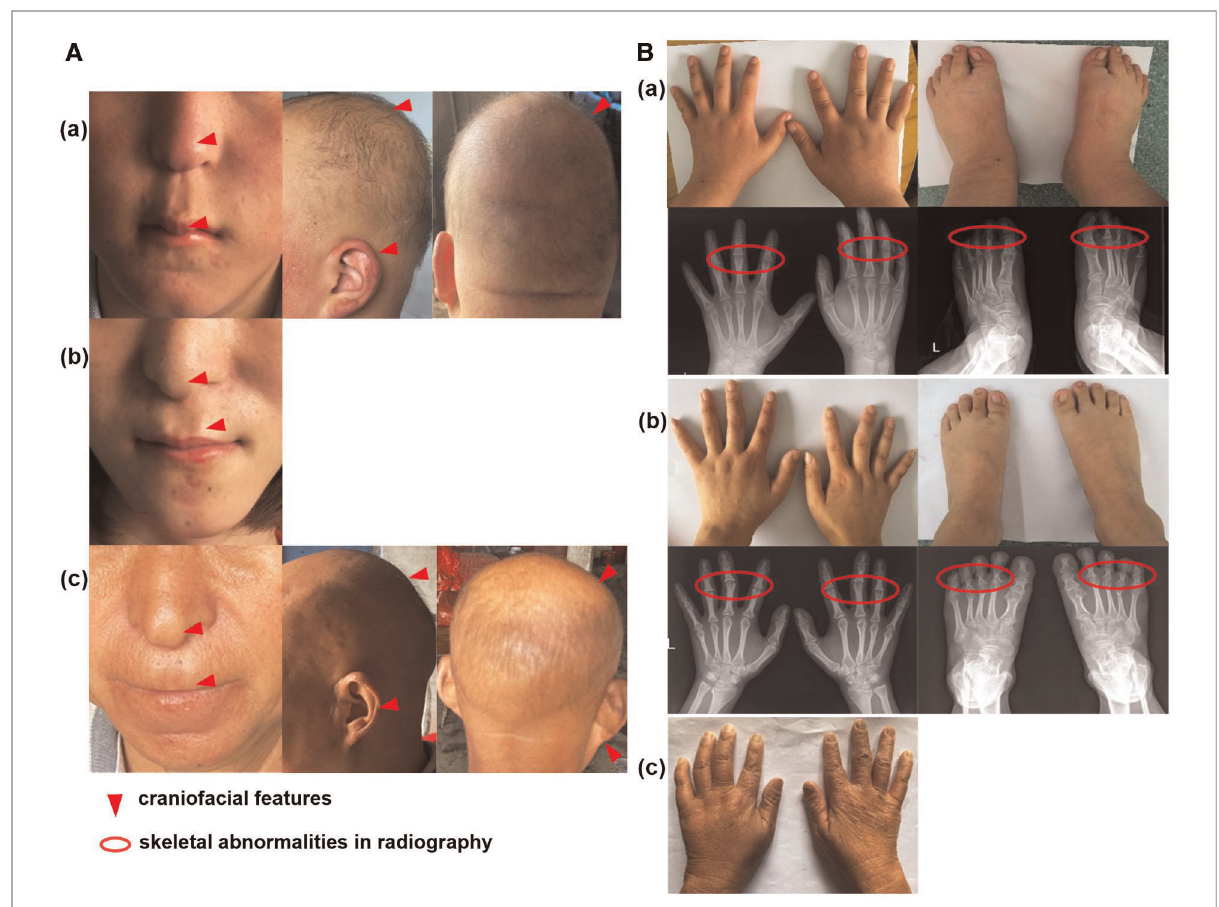
FIGURE 2 Clinical feature of the family cases. ( A ) The craniofacial feature of proband (a), his sister with wig (b) and mother (c); ( B ) The skeletal abnormalities of proband (a), his sister (b) and mother